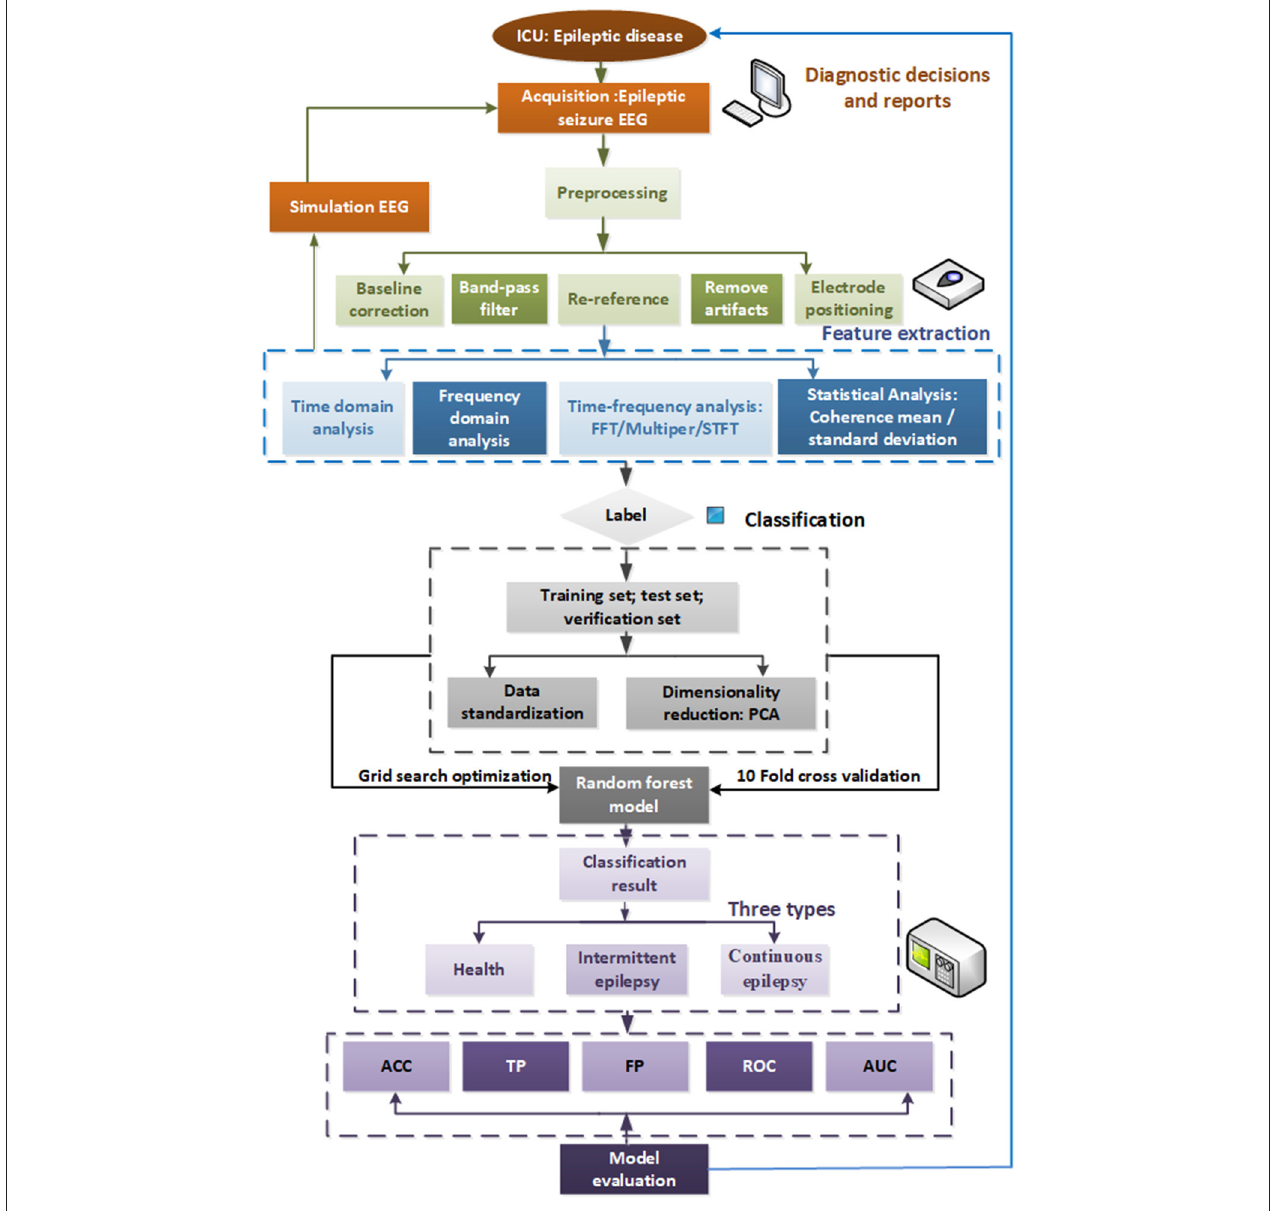
FIGURE 1 | Automatic detection framework for seizure